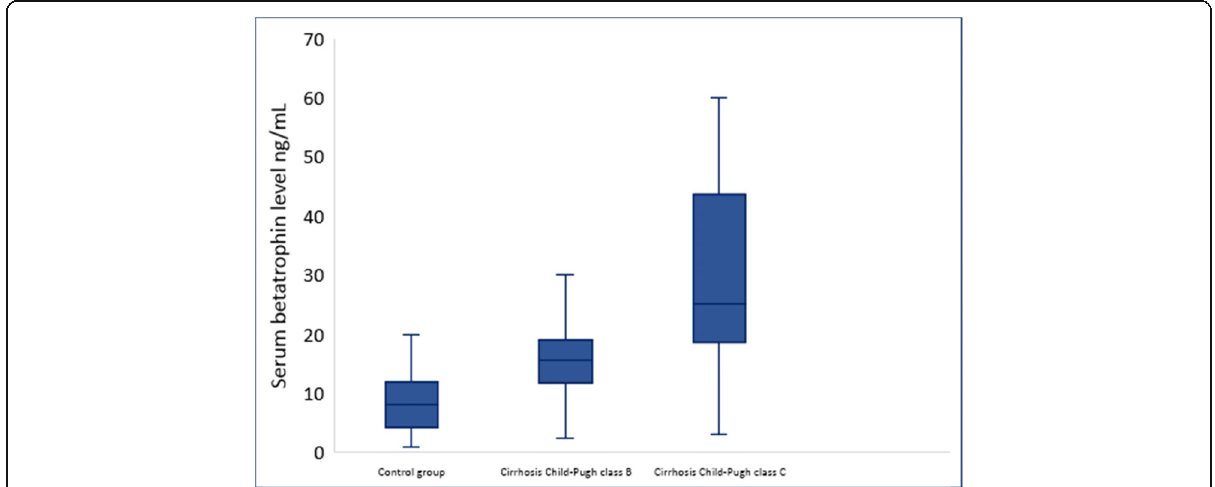
Fig. 2 Box plot showing serum betatrophin levels in patients with Child B and C cirrhosis and